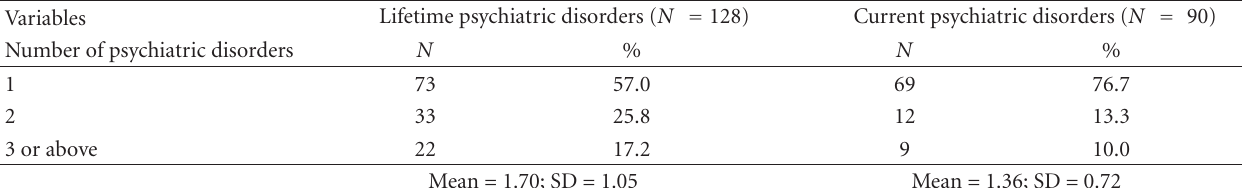
Table 4: Number of lifetime and current comorbid psychiatric disorders for pathological gamblers seeking treatment.